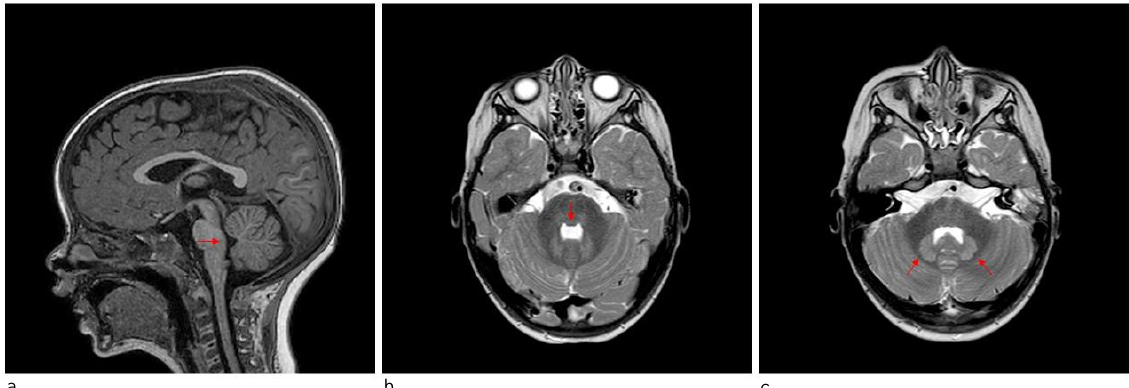
Figure 5. MRI of the brain of patient 2 showing ( a ) and ( b ) T1 and T2-weighted images confirming dysmorphism of the pons with fusion of the facial colliculi and bulging of the dorsal surface protruding into the fourth ventricle (arrows); ( c ) T2-weighted images show dentate nucleus and peridentate white matter hyperintensities (arrows).